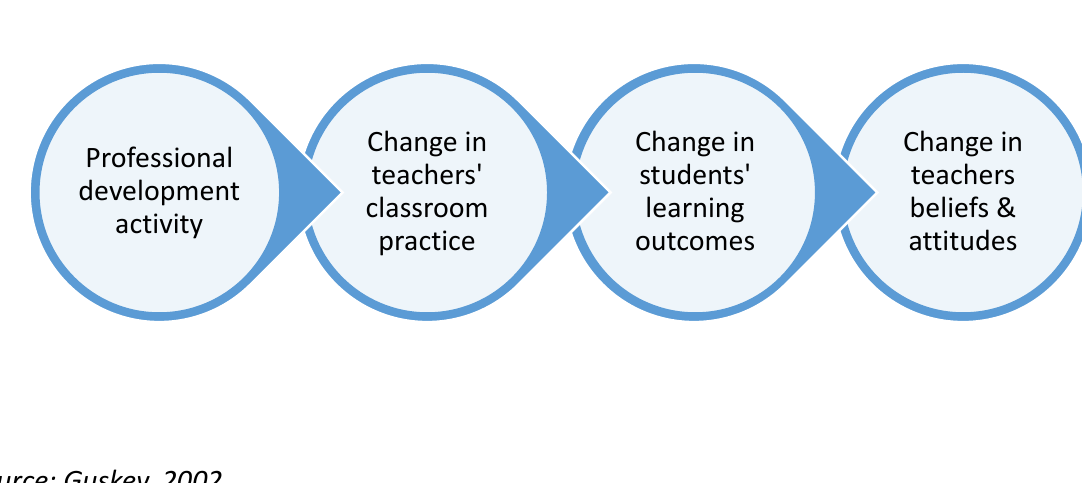
Figure 1. Model of teacher